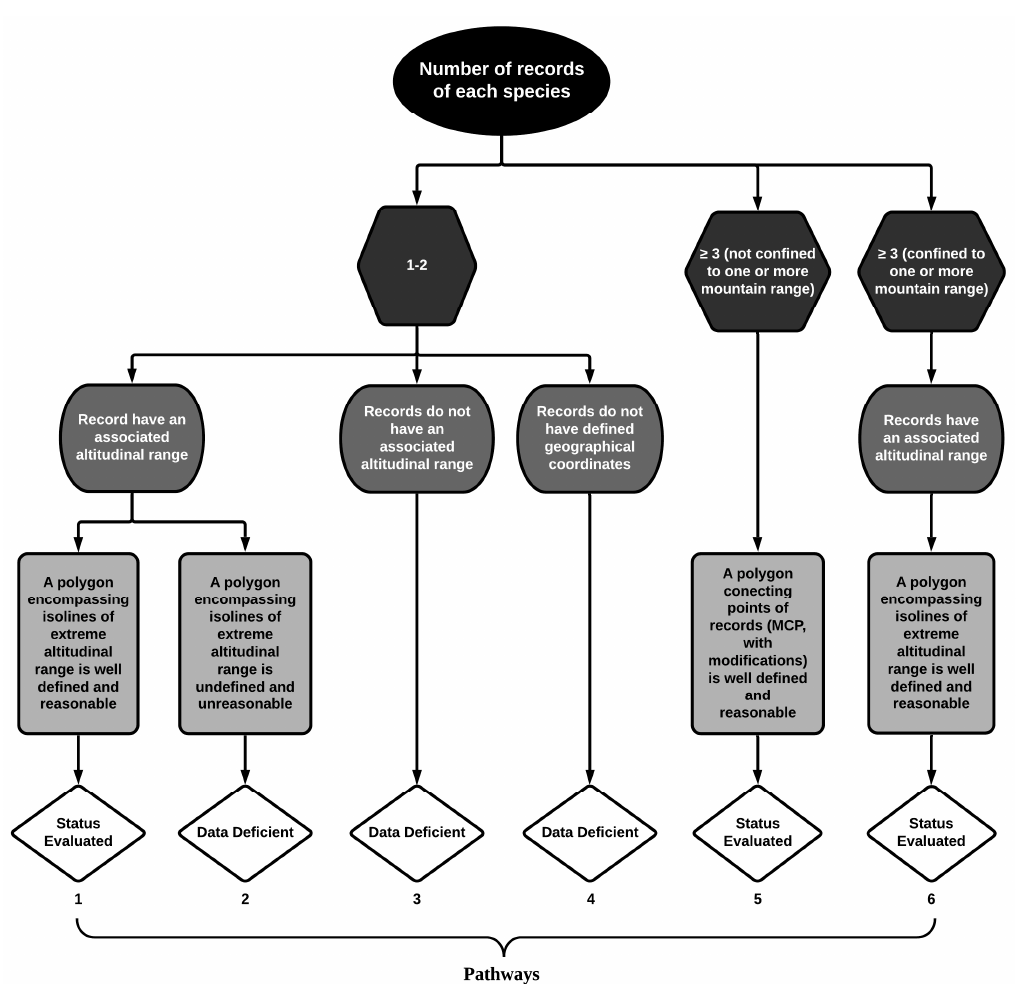
Figure 1. Flow chart indicating the approach to creating polygons of the extent of occurrence to compare the results with IUCN’s species extinction risk classification criteria [48].